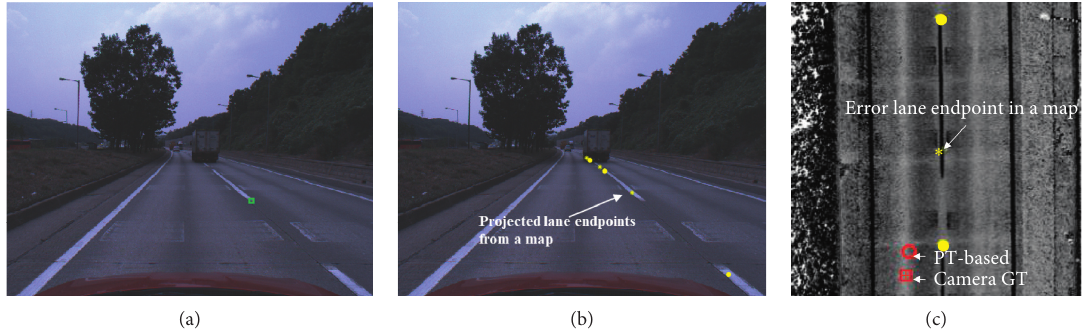
Figure 14: Example of large camera position error estimated with one detected lane endpoint: (a) detected lane endpoint; (b) projected lane endpoints from a map; (c) estimated camera